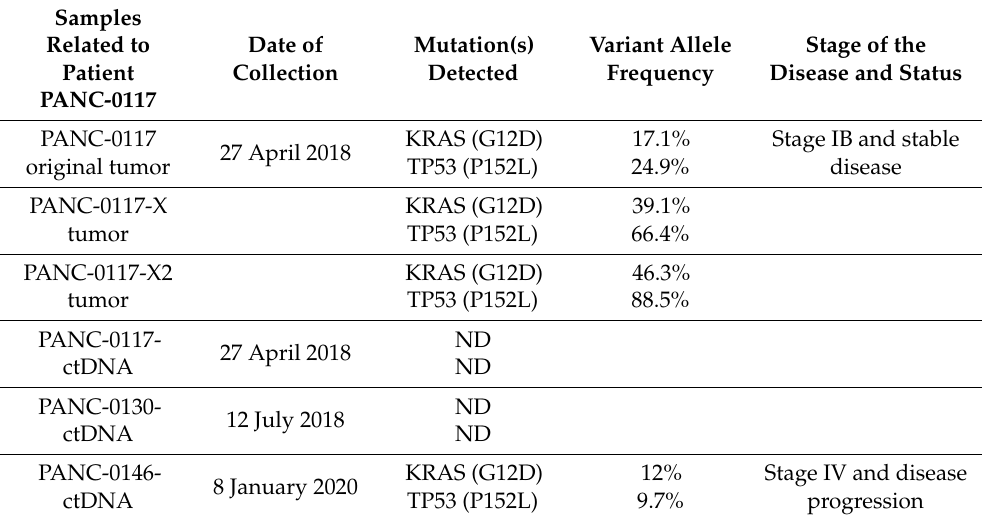
Table 2. Case report corresponding to a pancreatic cancer patient from whom three longitudinal blood samples were collected and analyzed for the presence of pathological mutations (ND = not